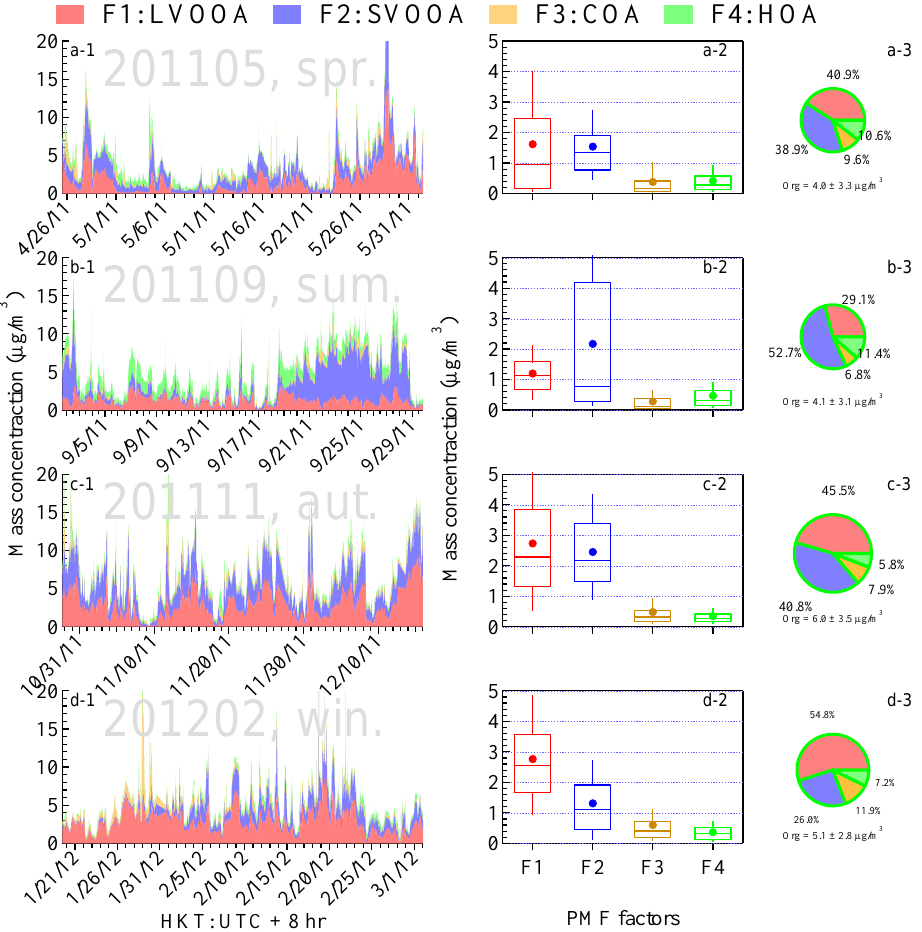
Figure 6. Summary of PMF-resolved organic factors (LVOOA, SVOOA, COA, and HOA) in NR-PM 1 in the 4 months. x-1: time series; x-2: monthly mean (dot), median (bar), 25 and 75% percentiles (box), and 10 and 90% percentiles (whiskers); x-3: monthly fraction (x-3), where “x” is “a” for spring (May 2011), “b” for summer (September 2011), “c” for autumn (November 2011), and “d” for winter (February 2012). Monthly averaged total organic concentrations are shown below the pie charts in x-3 with 1 standard deviation. The area of a pie chart is proportional to the organic concentration.